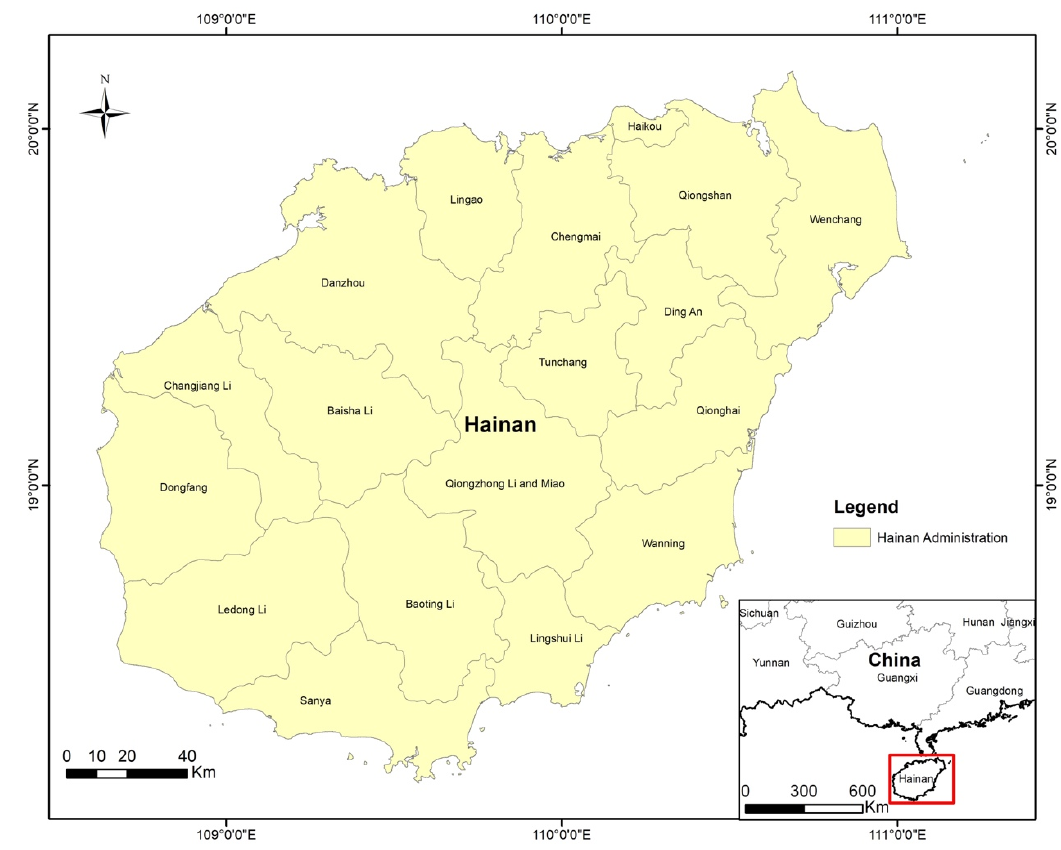
Figure 1. Map of the study area Hainan.